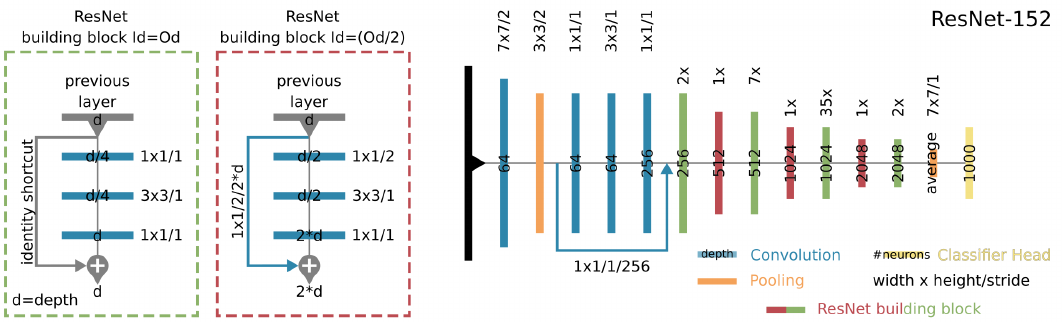
Figure 7. Conceptual overview of the ResNet building block and the ResNet-152 architecture [43]: ( Left ) The two ResNet building blocks show the convolutional operations in the main trunk, extracting features and the residual connections surrounding these operations to enable a more efficient transport of gradients during training. The difference between the two variants is that the first transports the input value of the block without changing it (identity shortcut) where the second uses convolution with stride 2, to match the output resolution and depth of the main trunk. ( Right ) Overall architecture of ResNet-152 consists of 152 layers due to stacked ResNet building